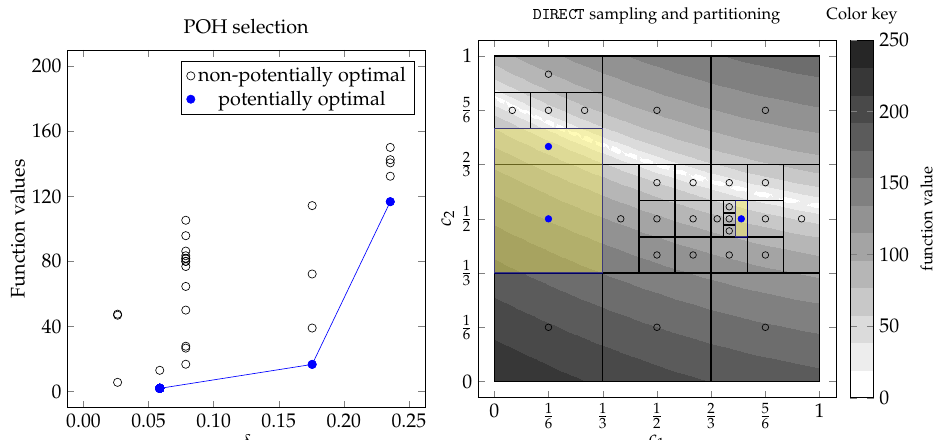
Figure 2. Visualization of selected potentially optimal rectangles in the fifth iteration of the DIRECT algorithm solving two-dimensional Bukin6 test problem.